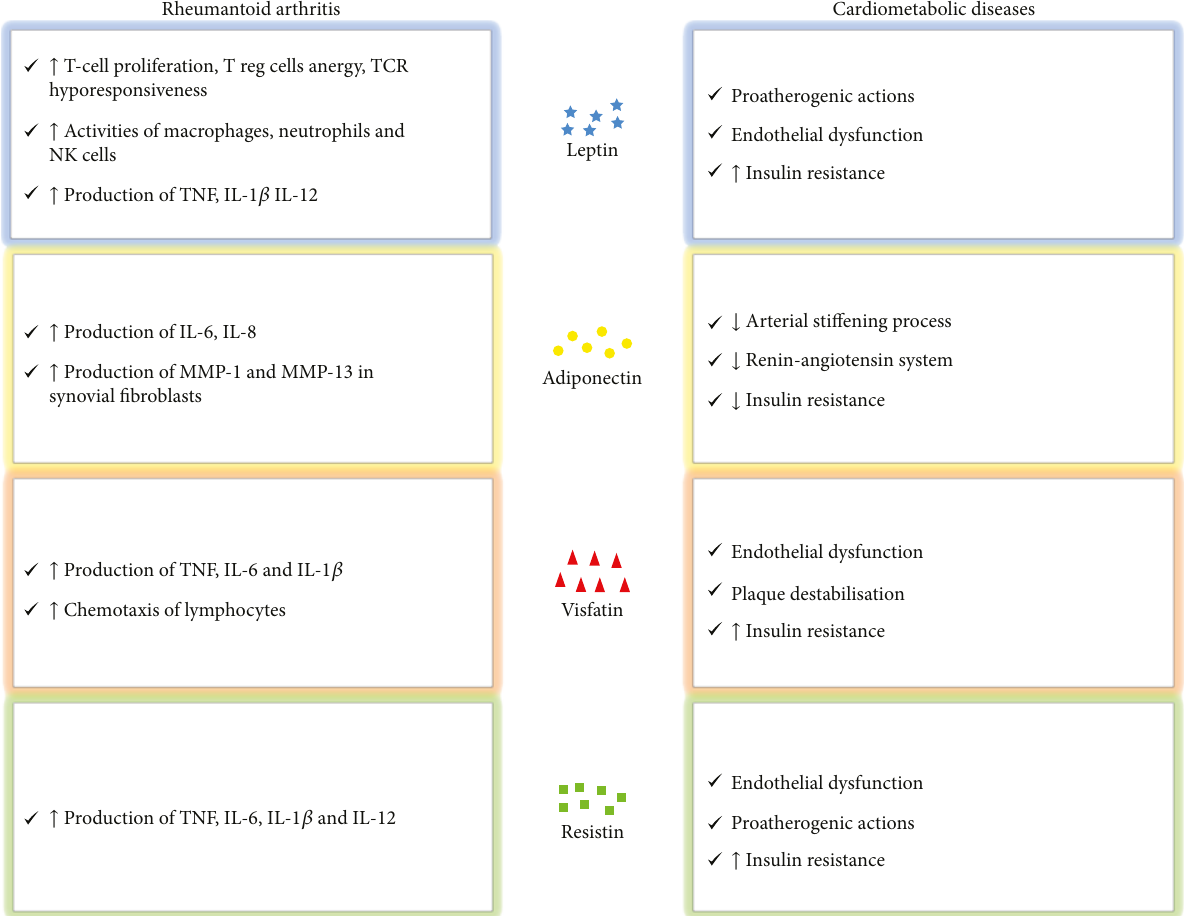
Figure 2: Pathogenic mechanisms of adipocytokines in rheumatoid arthritis and cardiometabolic diseases. Abbreviations: T Reg cells — T